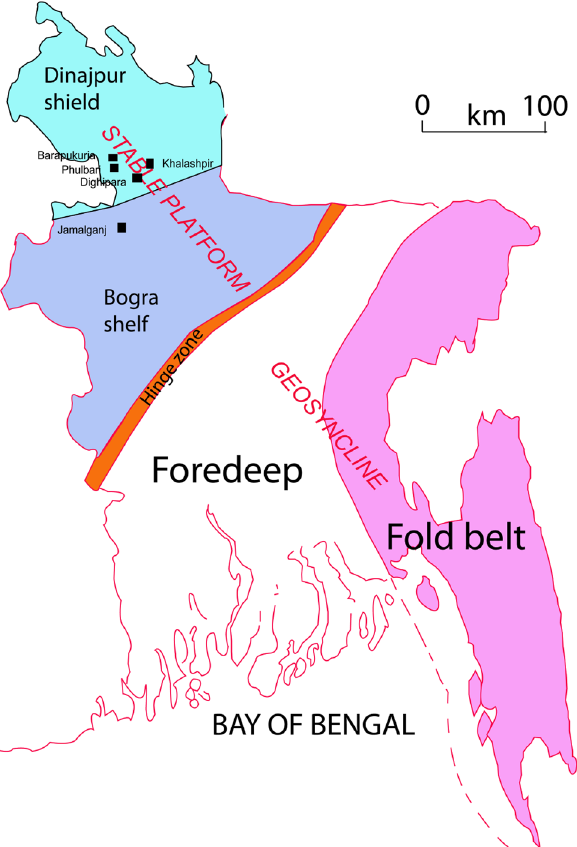
Figure 2. Structural framework and the coal basins of Bangladesh. (Modified after Imam 17 ). (Abobe Illustrator 10, https:// www. adobe. com/ produ cts/ illus trator.